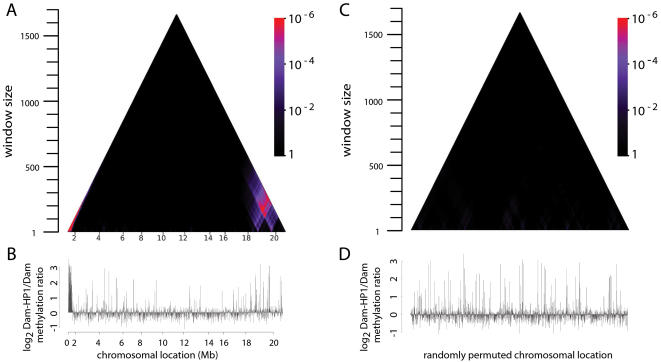
Visualization of chromatin domains by “domainograms”.To visualize local enrichment of a chromatin component, we calculate a probability score for the enrichment in a window of w neighboring genes under a null model in which all genes are randomly permuted. This calculation is done for all possible windows, ranging in size from a single gene to all genes on an entire chromosome arm, and for all possible window positions. A color scale (ranging from black for non-significant scores close to 1, to red for highly significant scores <10−6, see color scalebar) is used to visualize the probability scores in a triangular graph, which we term “domainogram”. Horizontally, each score is plotted at the chromosomal position of the center of the window, and vertically the windows are ordered by size. Thus, we obtain an intuitive visualization of local enrichments at all possible scales. See Methods for a detailed description. A) Domainogram of HP1 binding on the right arm of chromosome 2. B) Genomic map of HP1 binding used to generate the domainogram. C–D) domainogram plot and corresponding binding map after random permutation of the HP1 binding values along the genome. Genomic locations (Mb) are indicated below each graph in A–B.